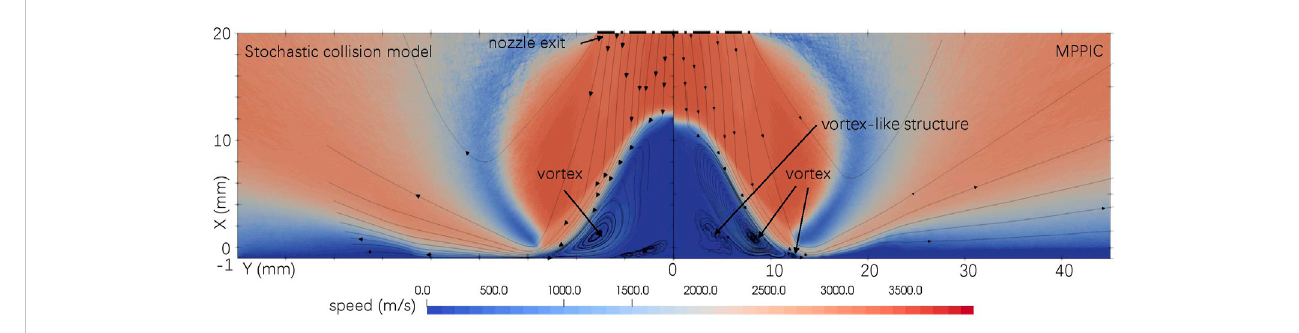
Comparison of gas velocity fi eld between the stochastic collision model and MPPIC at t = 0.375 m.